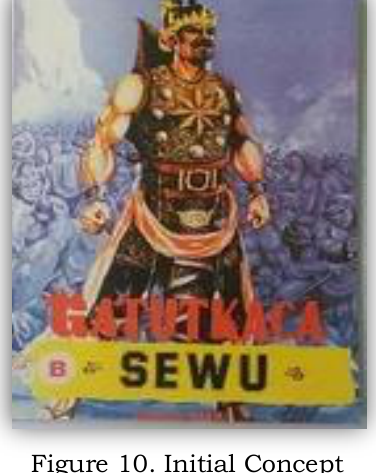
Figure 11. Modern Concept